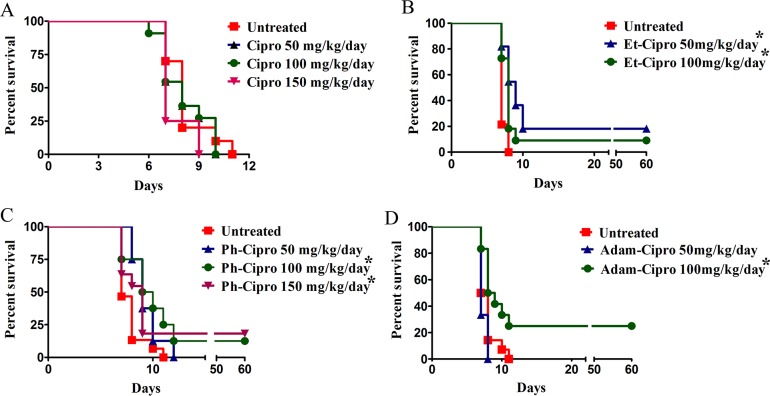
Effect of 7-day treatment with different doses of Cipro derivatives on the survival mice.Swiss Webster mice were infected i.p. with 5x103 tachyzoites of T. gondii (RH strain) one day prior to the start of treatment. Results were evaluated by the Kaplan-Meier product limit method, and compared using the log-rank (Mantel-Cox) test. * P<0.05 vs. untreated controls. The numbers of treated mice in each group were: untreated, 10 (A), 14 (B and D) and 15 (C); 50 and 100 mg Cipro, 11 (three groups each); 150 mg Cipro, 8 (two groups); 50 and 100 mg Et-Cipro, 11 (three groups); 50 and 100 mg Ph-Cipro, 8 (two groups); 150 mg Ph-Cipro, 11 (three groups); 50 mg Adam-Cipro, 3 (one group); 100 mg Adam-Cipro, 12 (three groups).